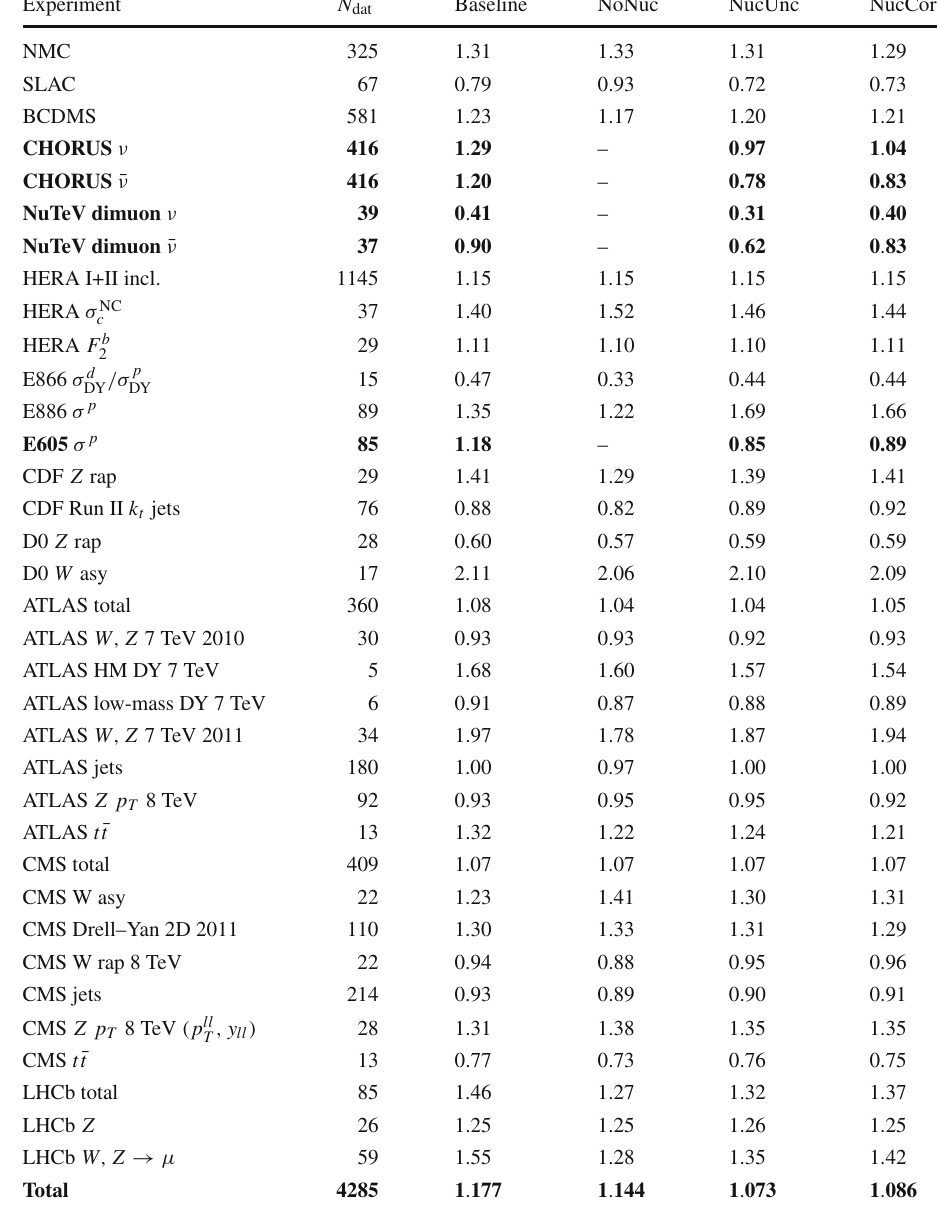
Table 3 The values of the χ 2 per data point for the various fits described in the text. Data sets that utilise a nuclear target other than a deuteron are highlighted in